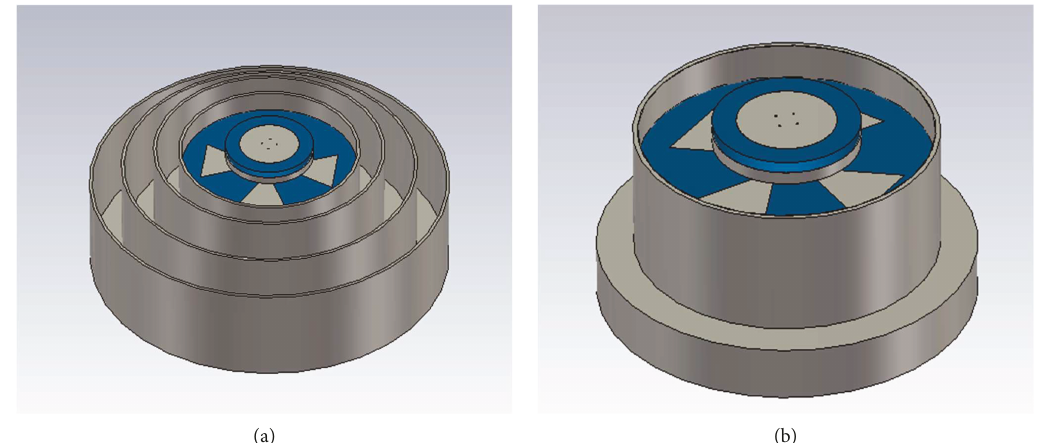
Figure 9: (a) L/S antenna with the choke ring; (b) L/S antenna without the choke